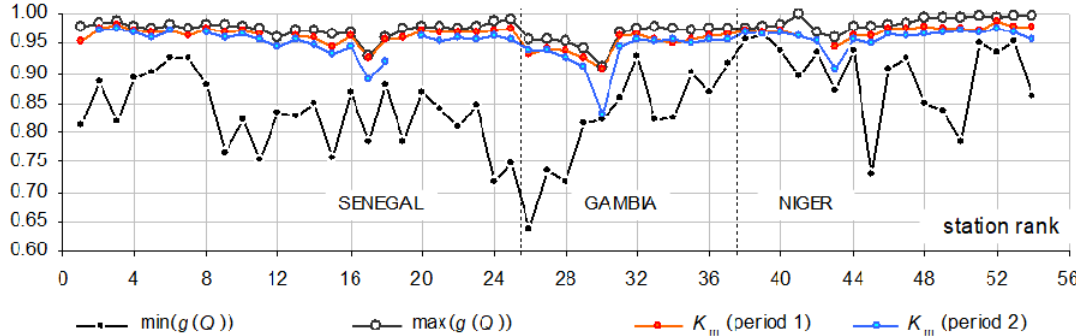
Figure 16. Mean K m of K observed over each period 1 and 2 and minimum and maximum values of K modeled as a function of discharge (model K = g ( Q ) calibrated on all observations).